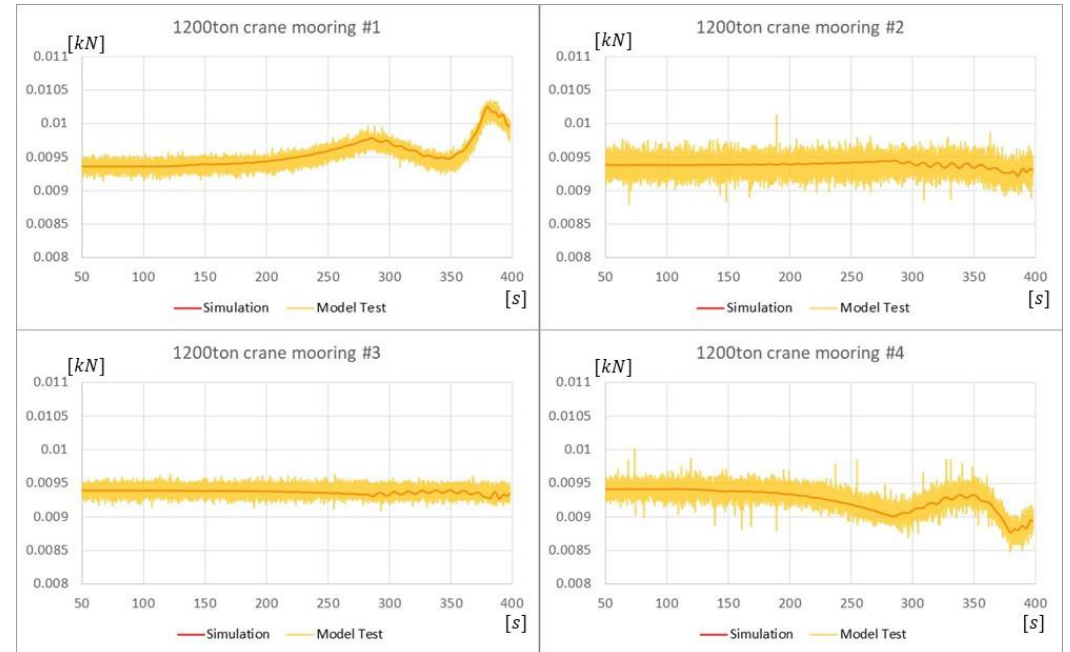
Figure 21. Tension of mooring lines for 1200-ton crane model.